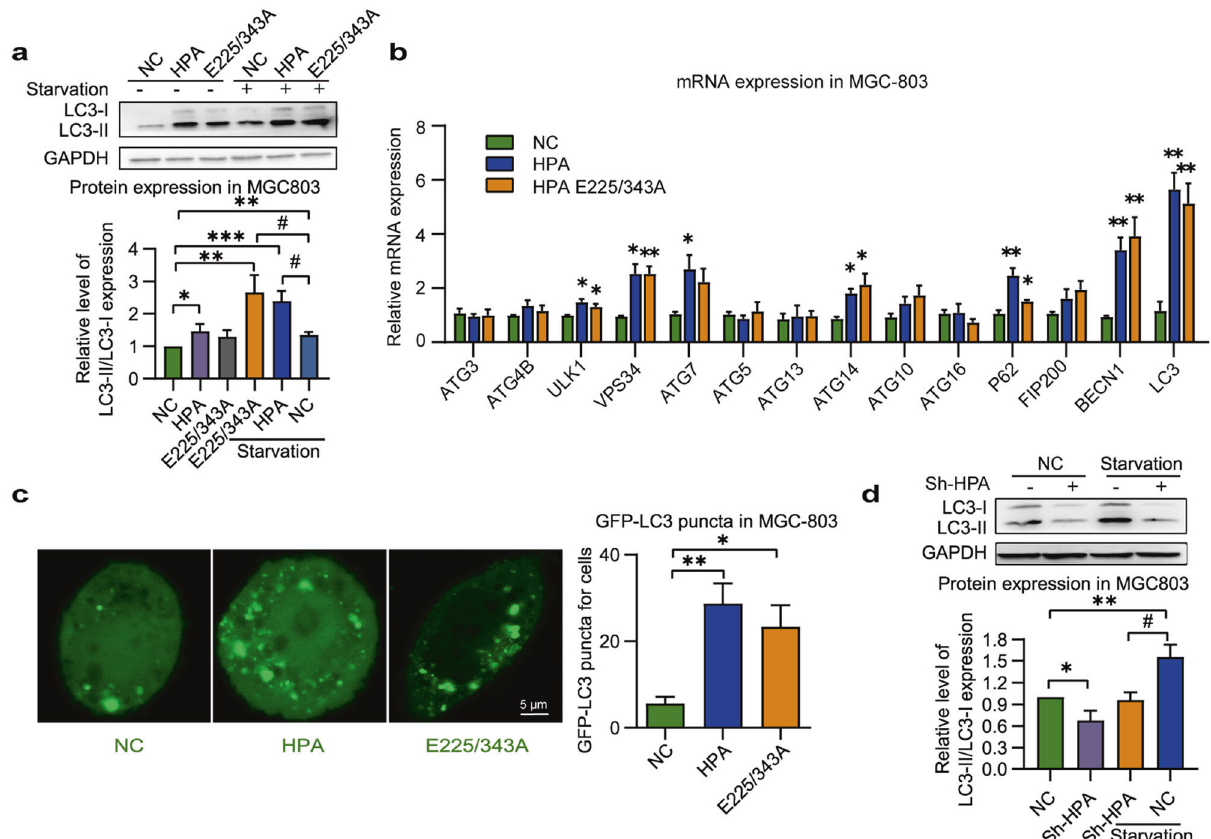
Fig. 2 Autophagosome formation in MGC803 cells overexpressing wild-type and nonenzymatic HPA. a Western blot analysis of LC3-II in MGC803 cells overexpressing native or mutant HPA, in the absence or presence of starvation. Glyceraldehyde-3-phosphate dehydrogenase (GAPDH) was used as a loading control. b Autophagosome formation-related gene expression in MGC803 cells overexpressing native or mutant HPA with deprivation of nutrients for 4 h. c Formation of GFP-LC3 puncta analyzed and quanti fi ed in MGC803 cells overexpressing native or mutant HPA and subjected to starvation. d Representative immunoblot of LC3-II in MKN45 cells after HPA gene knockdown and starvation. GAPDH was used as a loading control. * P < 0.05, ** P < 0.01, *** P < 0.001 versus the NC group, # P < 0.05 versus the NC + starvation